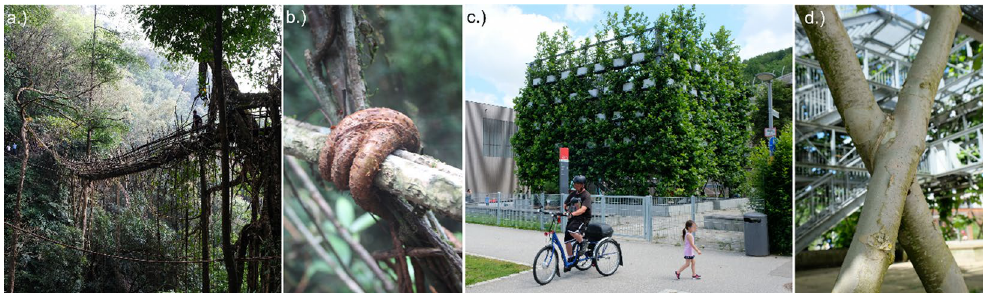
Figure 1. Living architecture exhibits points of interest on a range of scales: ( a ) a 53 m long living root bridge (photo: W. Middleton), ( b ) details in bridges are at the cm scale (W. Middleton), ( c ) the Nagold Plane Tree